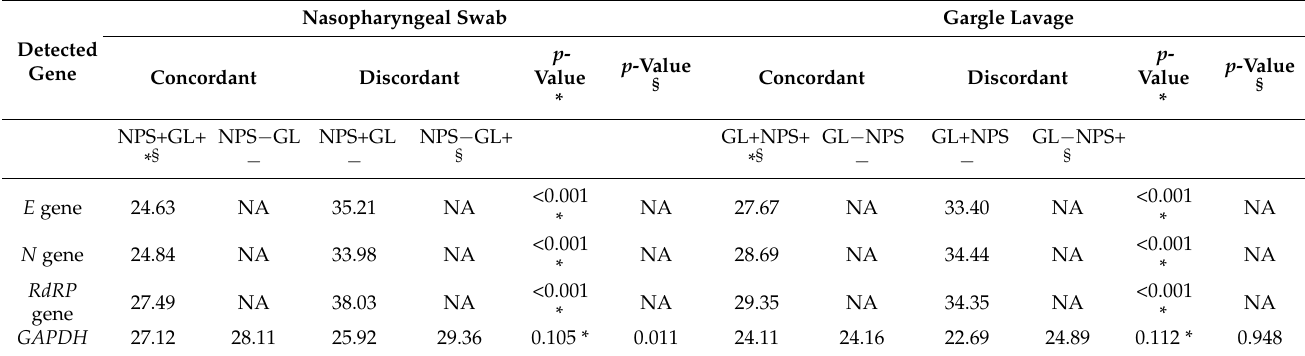
Table 3. Comparison of median Ct values in nasopharyngeal swab and gargle lavage samples based on the agreement of SARS-CoV-2 test results with paired samples.